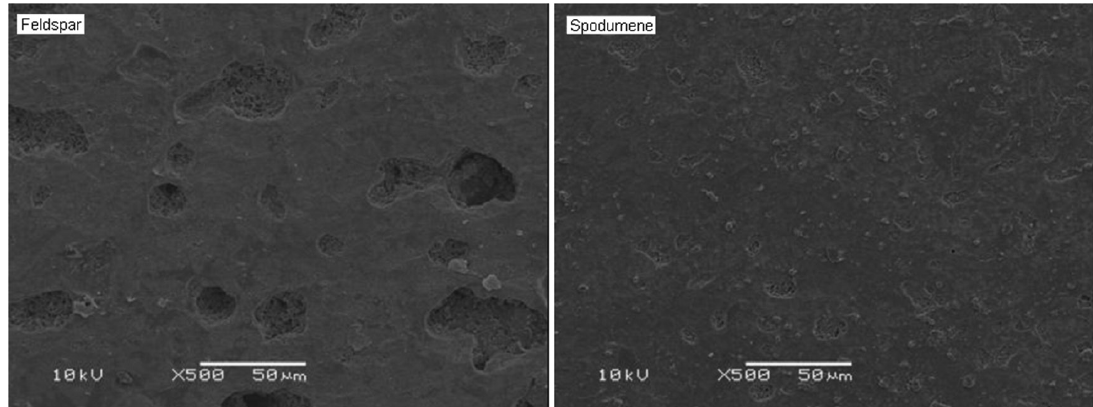
Figure 4. Images (SEM): no chemical etching Feldspar, and spodumene bodies fired at 1240 °C.